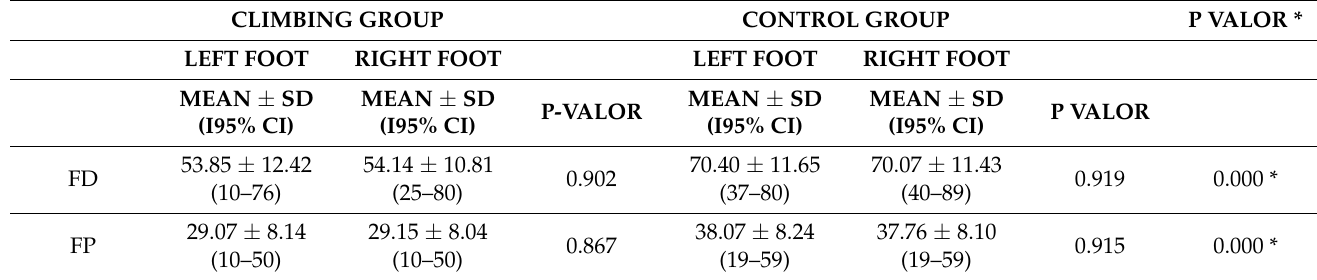
Table 6. Movement of the first metatarsophalangeal joint of all